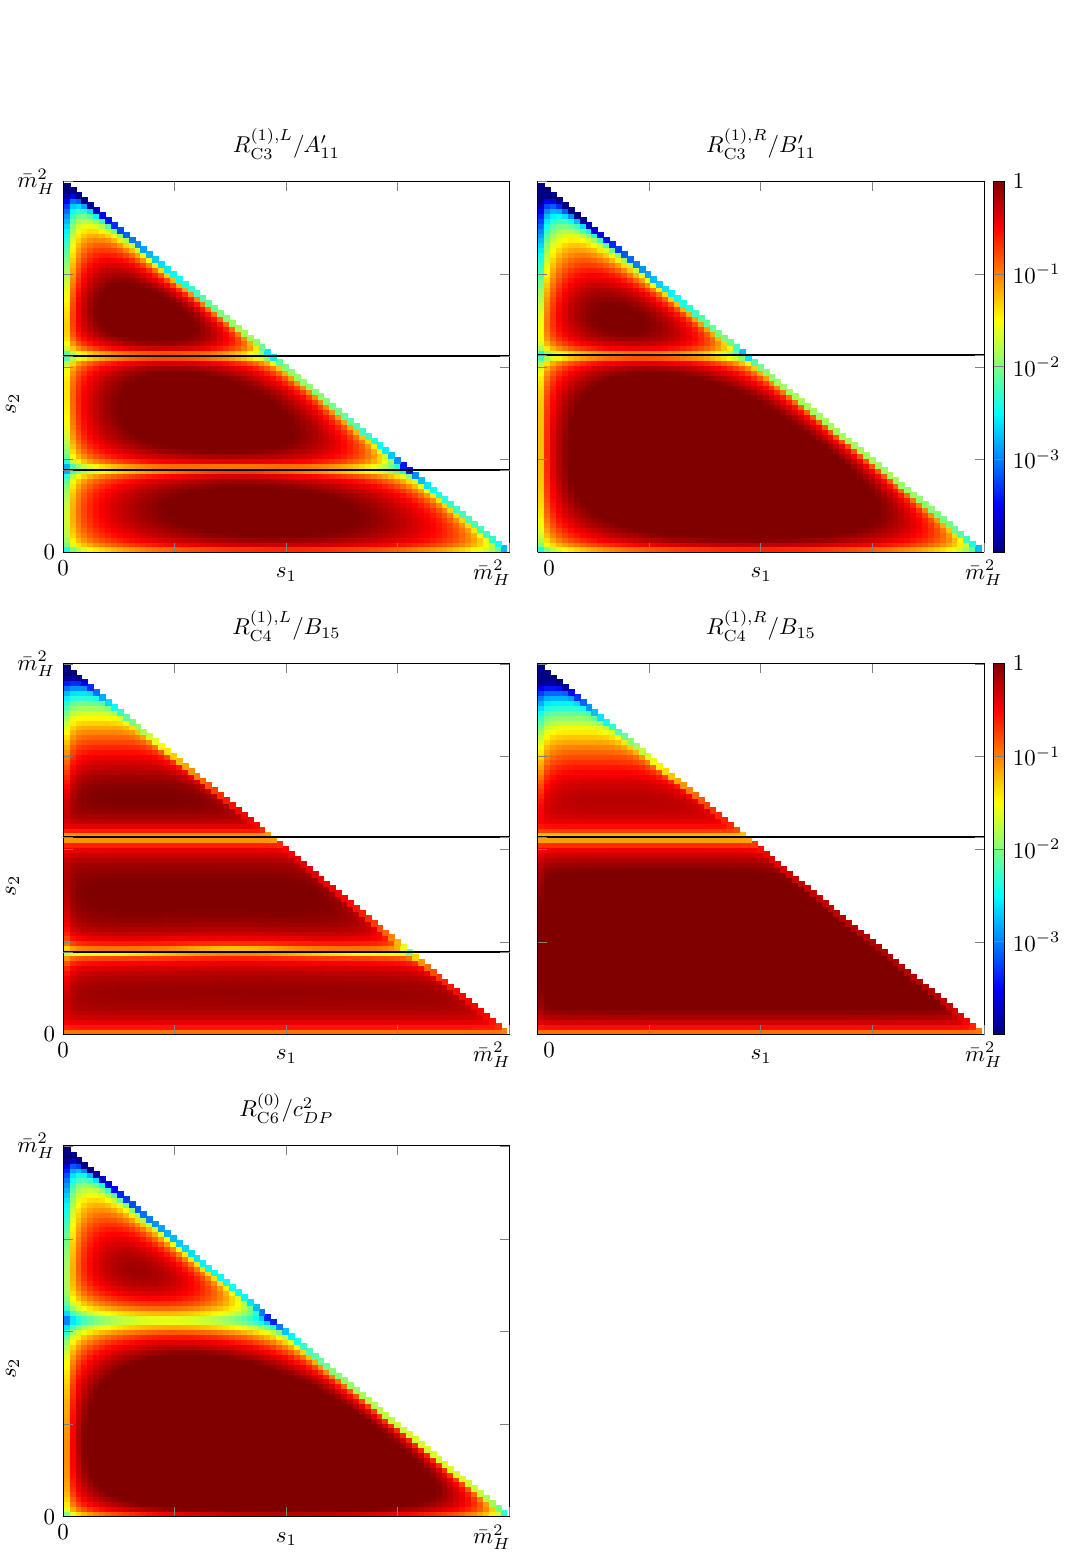
Figure 7: Dalitz-like plots as described in Figure